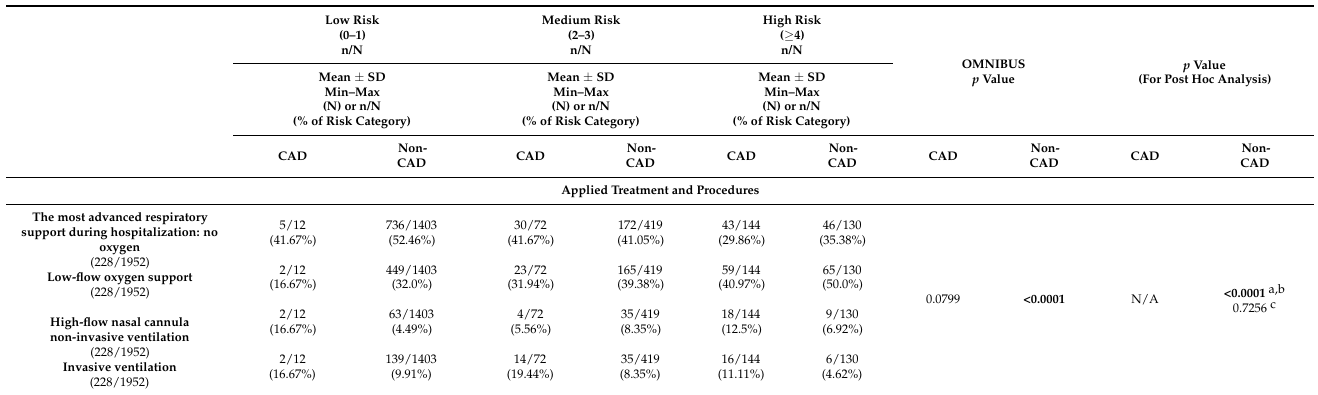
Table 6. Applied treatment and